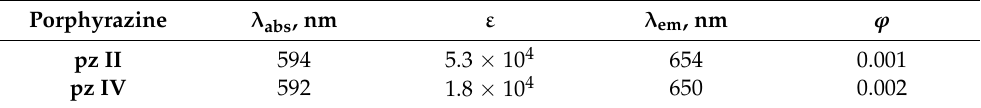
λabs, maxima of absorption spectra; λem, maxima of fluorescence spectra; ε, molar extinction coef- ficient (L × mol−1 × cm−1); φ, quantum yield .